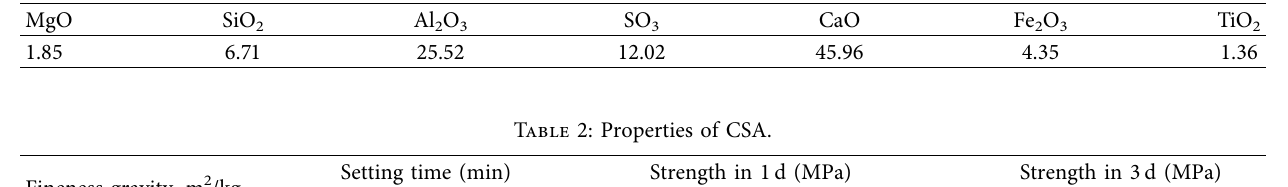
Table 1: Chemical compositions of CSA (%).